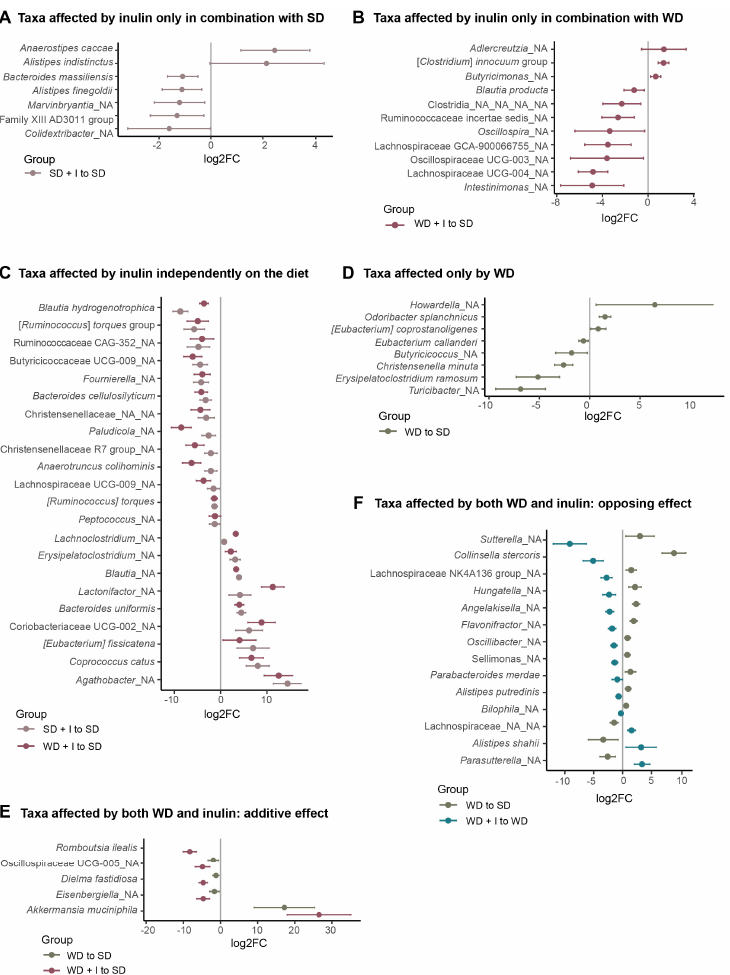
Figure 4. Bacterial taxa significantly affected by diet and/or inulin. ( A ): Taxa affected by inulin only in combination with SD (adj_pval VG_SD + I vs VG_SD < 0.1); ( B ): Taxa affected by inulin only in combination with WD (adj_pval VG_WD + I vs VG_SD < 0.1); ( C ): Taxa affected by inulin independently on the diet (adj_pval VG_SD + I vs VG_SD < 0.1 and adj_pval VG_WD + I vs VG_SD < 0.1); ( D ): Taxa affected only by WD (adj_pval VG_WD vs VG_SD < 0.1); ( E ) Taxa affected by both WD and inulin: additive effect (adj_pval VG_WD vs VG_SD < 0.1 and adj_pval VG_WD + I vs VG_WD < 0.1, effect size VG_WD vs VG_SD and VG_WD vs VG_WD + I in the same direction); ( F ) Taxa affected by both WD and inulin: opposing effect (adj_pval VG_WD vs VG_SD < 0.1 and adj_pval VG_WD + I vs VG_WD < 0.1, effect size VG_WD vs VG_SD and VG_WD vs VG_WD + I in the opposite direction). The taxa were selected according to the outcome of the univariable statistic test (Kruskal–Wallis), omnibus adj_pval < 0.1. The graph shows the effect size calculated as log2FC. adj_pval, adjusted p -value; FC, fold